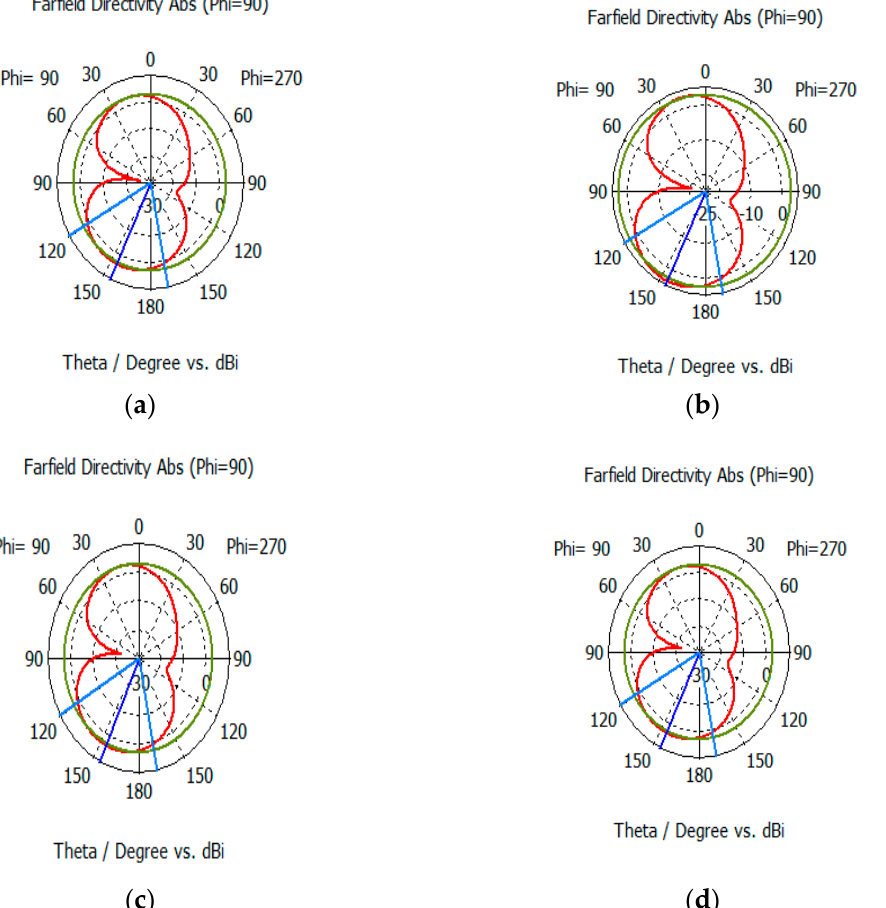
Figure 9. Simulated radiation pattern plot at 5.5 GHz of frequency-reconfigurable rectangular patch antenna with two V-shaped extrudes with DGS: ( a ) D1(ON) and D2(ON); ( b ) D1(OFF) and D2(ON); ( c ) D1(ON) and D2(OFF); ( d ) D1(OFF) and D2(OFF).